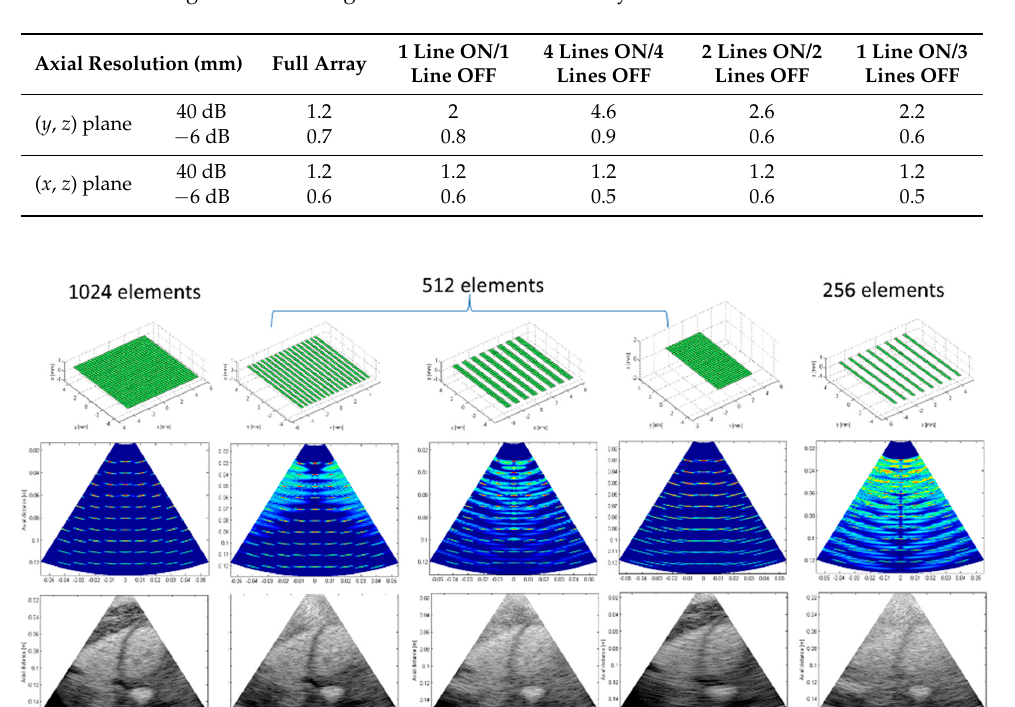
Table 3. Axial resolution (the mean value) measured in ( x , z ) and ( y , z ) planes for the equidistant scatters when using different configurations of the matrix array.